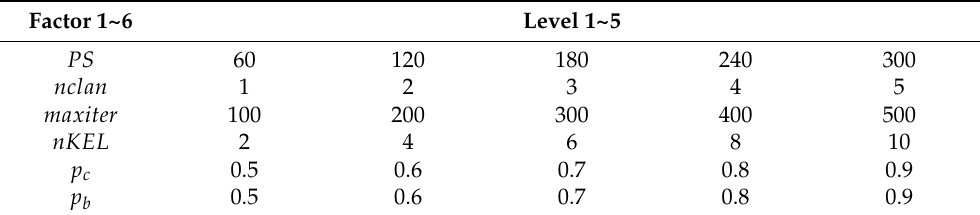
Table 3. Parameter levels.